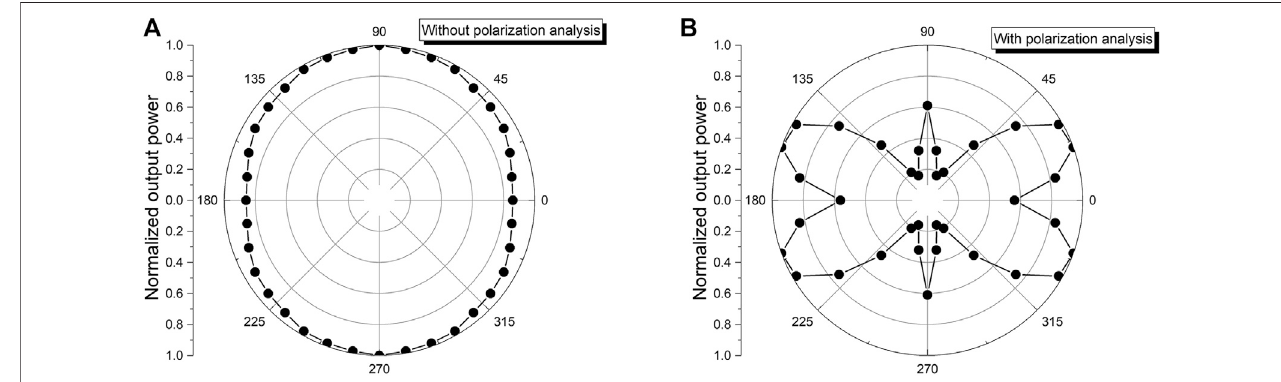
FIGURE 8 | Polarization dependence of the guided light at 633 nm. (A) Incident polarization dependence of the transmitted power, (B) Polarization analysis of the output light mode.